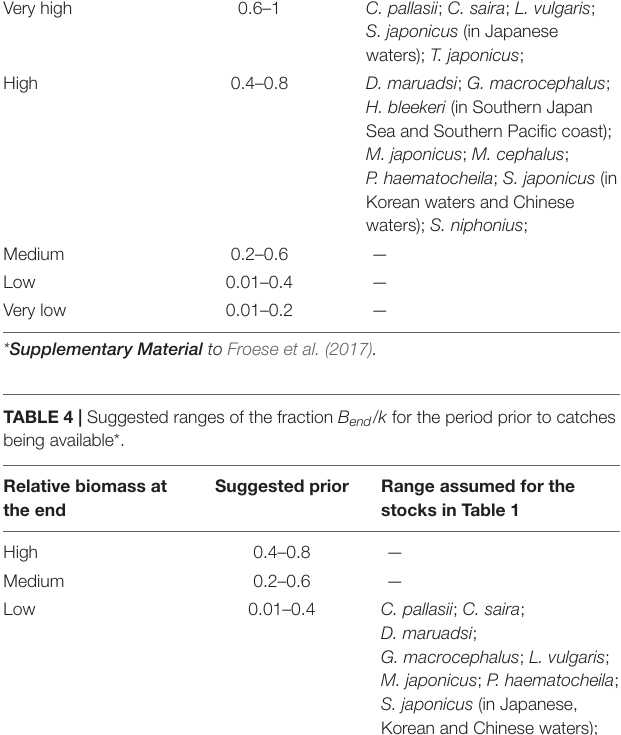
TABLE 3 | Suggested fractions B start / k for the period before catch data became available*. Relative biomass Suggested prior Range assumed for the stocks at the start in Table 1